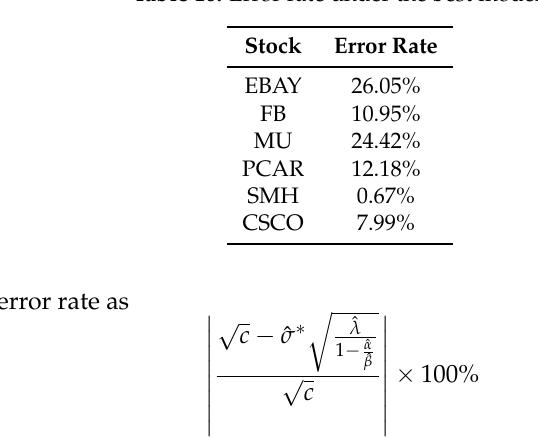
Figure 8. Error measurements for 6 stocks. Table 10. Error rate under the best